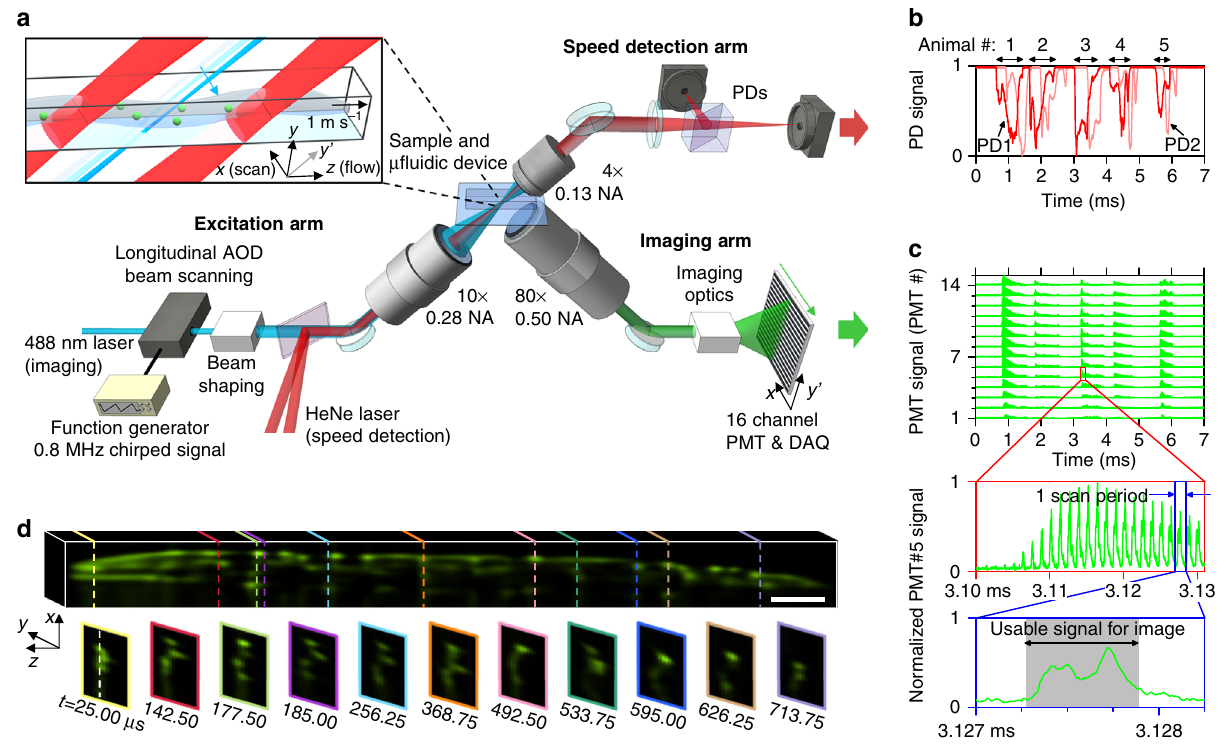
Fig. 1 Overview of 0.8 million frames per second line excitation array detection (LEAD) fl uorescence microscopy, implemented as a 3D whole-animal fl ow cytometer. a Schematic of the imaging system. A longitudinal TeO 2 AOD driven with a chirped frequency scans the laser excitation beam across an angled plane on the sample at 0.8 MHz. The excited plane is imaged onto 14 channels of a 16-channel photomultiplier tube (PMT) array, capturing a full frame each scan cycle. A micro fl uidic device delivers populations of hundreds of C. elegans at ~1 m s − 1 through the excitation region (inset). Two light sheets generated by a HeNe laser and two photodiodes (PDs) detect animal velocity through the imaging region. b Representative PD and ( c ) PMT signals from fi ve animals imaged within 7 ms. A drop in transmission of the PD signals indicates the presence of an animal, and the time delay between the two PD signals indicates the velocity. The fl uorescence signals collected by the 14 PMT channels and acquired at 100 MHz rate are used to generate volumetric images. (Red Inset) The fl uorescence signal from the head of an animal is shown for a single PMT over several scan periods. (Blue Inset) The signal from a single PMT during a 1.25 µ s scan cycle forms one line ( x -direction) in the image. The gray shaded region is the usable imaging period when the upchirped AOD driving signal scans the focused beam across the sample. d A 3D reconstruction of a polyglutamine aggregation model C. elegans (with proteins tagged with YFP) moving at an average velocity 0.89 m s − 1 imaged in 0.79 ms with our system. The volumetric image consists of 631 x – y frames (each 66 × 14 pixels) captured every 1.25 μ s, with each PMT element recording a section of the sample in the y '-direction (PMT #7 is shown). Scale bar = 50 μ